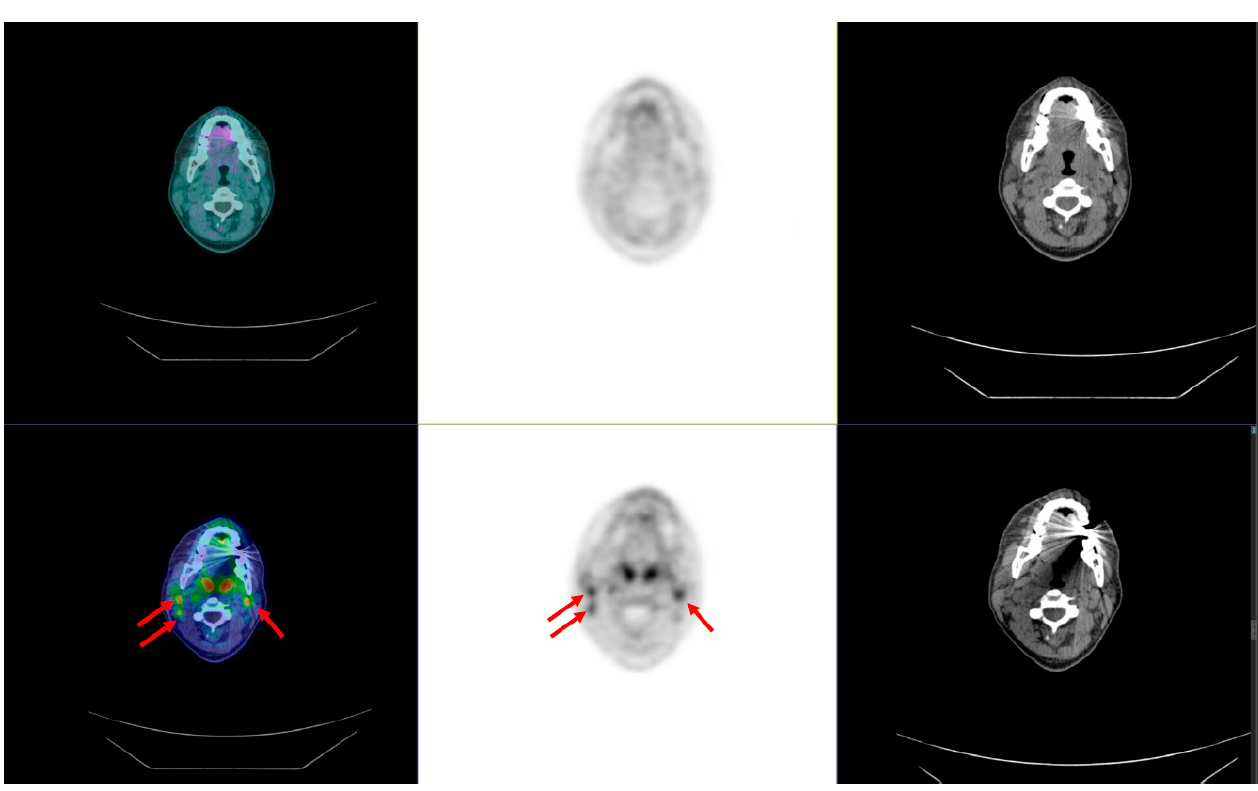
Figure 8. Bifocal and bilateral medullary thyroid carcinoma. Preoperative PET/CT: arrows showing bilateral lymph node metastases negative at [ 18 F]FDOPA ( top ) and positive at [ 18 F]F ‐ SiFAlinTATE ( bottom ).